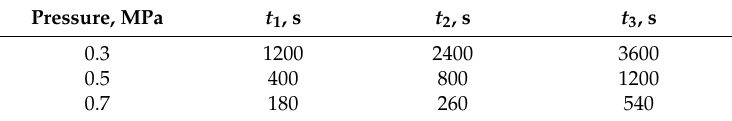
Table 2. Time values for different pressures.